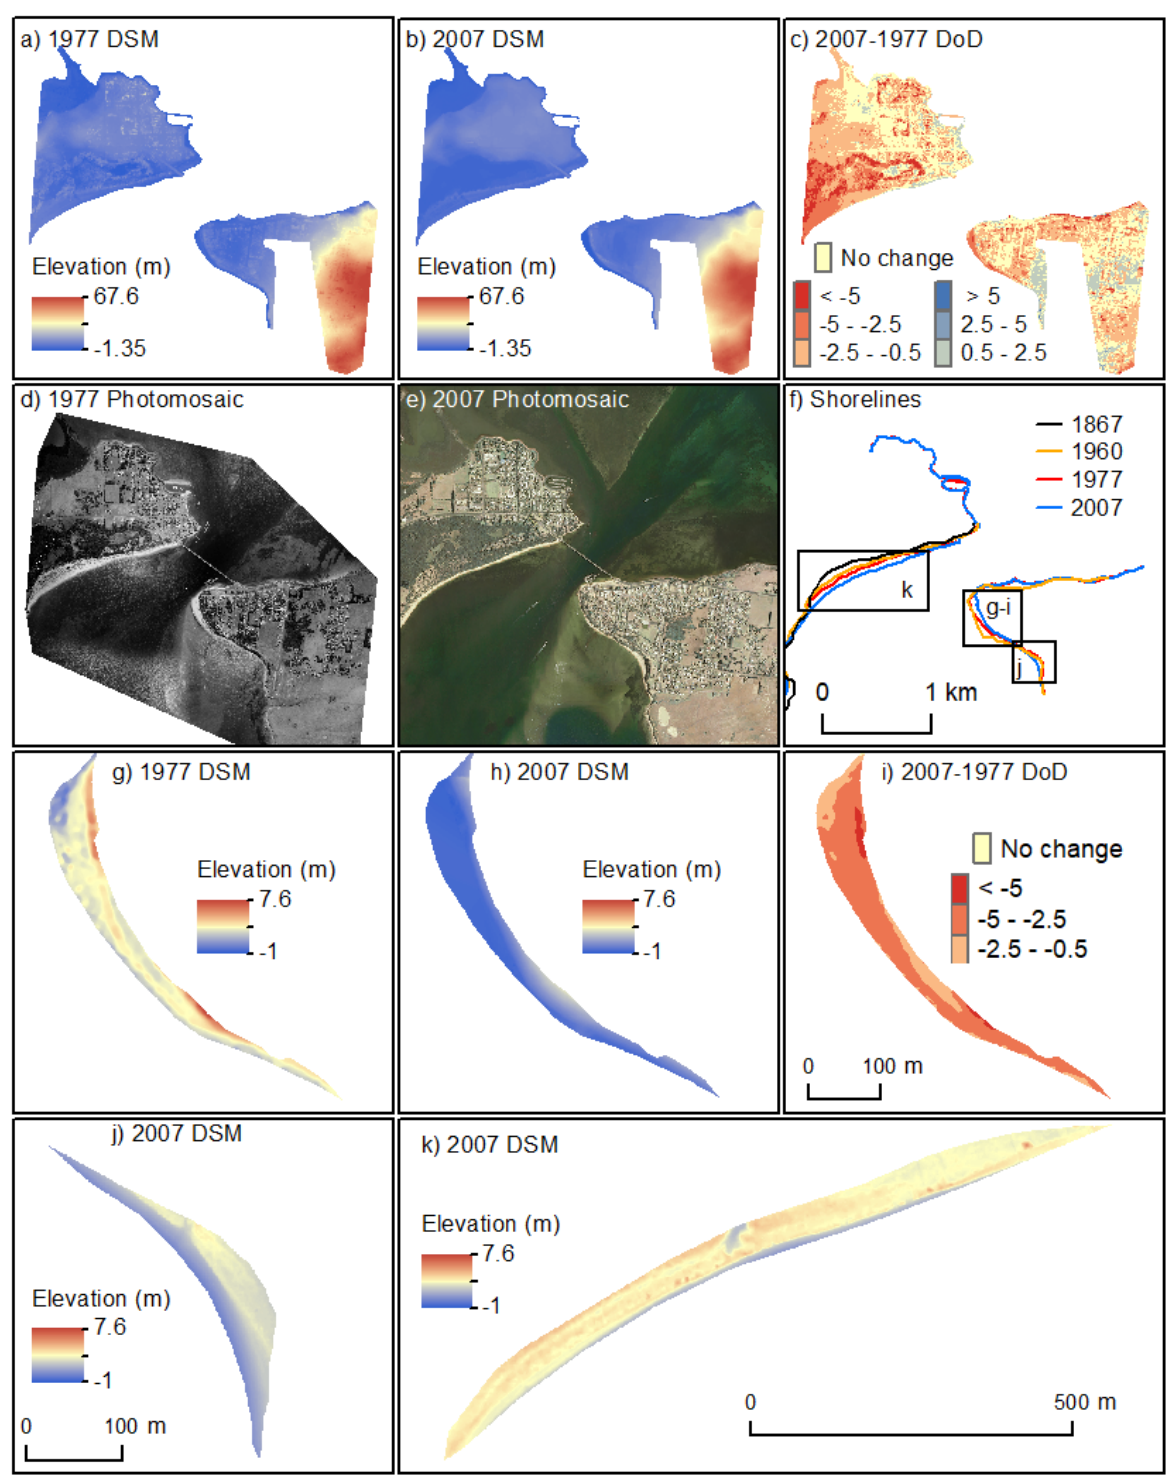
Figure 5. DSMs ( a , b ), DoD ( c ), photomosaics ( d , e ) and digitised shoreline ( f ) comparison. Specific DSMs ( g , h ) and DoD ( i ) show erosion observed at San Remo-Childrens beaches, whereas 2007 DSMs show subaerial deposition (accretion) experienced at Back Beach ( j ) and Newhaven Beach ( k ). Negative values (red) in DoDs indicate areas of erosion, whereas positive values (blue) indi- cate areas where deposition occurred. An absolute value of 0.5 m based on the RMSE was used to represent areas of no change (yellow). Auxiliary digitised shorelines are added for comparison ( f ). The 1977 DSM ( a ) and photomosaic ( d ) are available as Supplementary